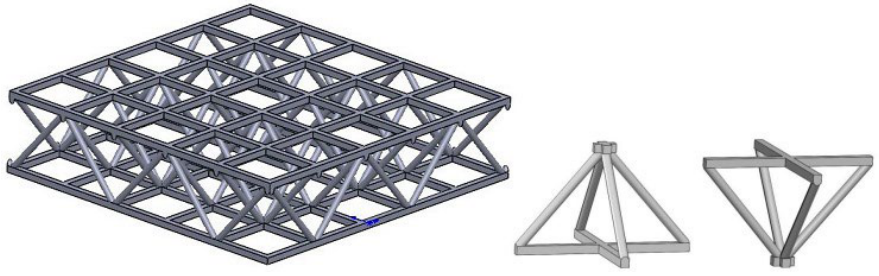
Figure 8. Warren truss slot resin reinforcement structure and the tetrahedral truss lattice cell.